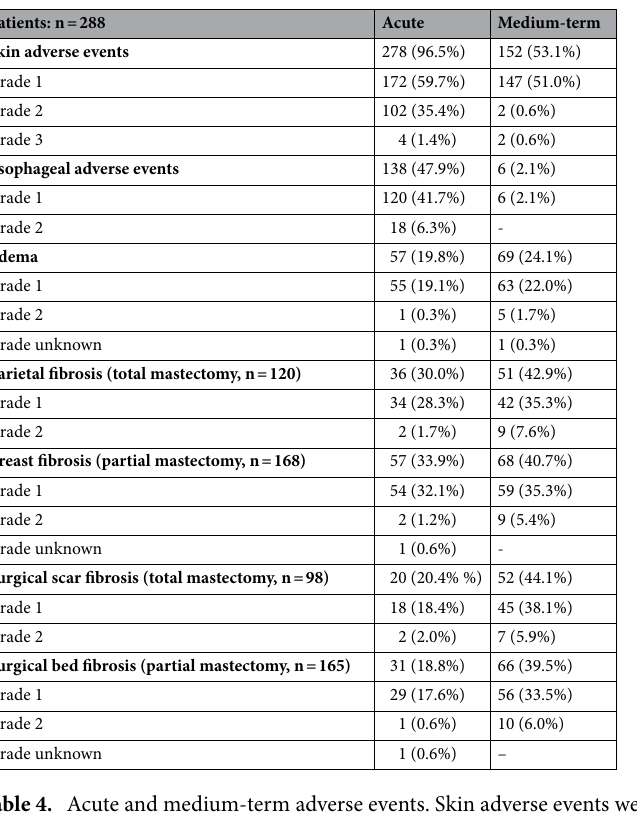
Table 4. Acute and medium-term adverse events. Skin adverse events were defined as radiodermatitis, ulceration-necrosis, telangiectasia, atrophy, hyperpigmentation or hypopigmentation. With regard to surgical bed fibrosis, only fibrosis absent on inclusion or of a higher grade on inclusion was considered.